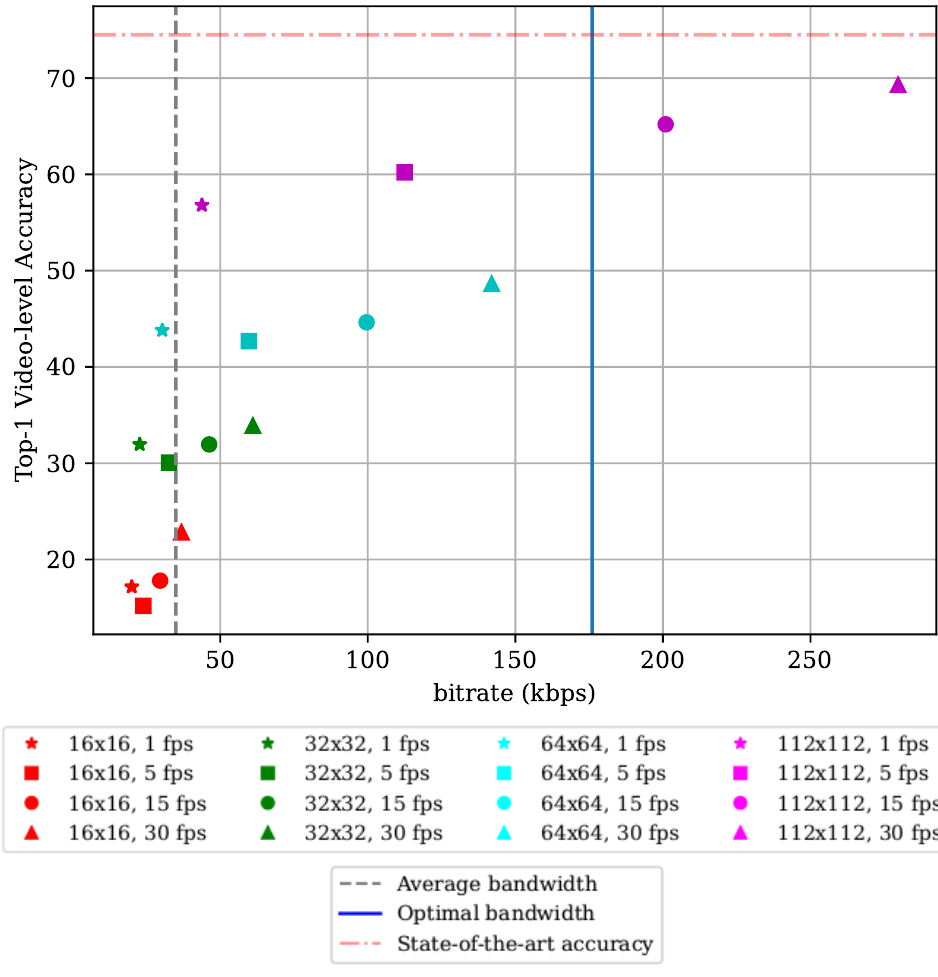
Figure 8. Plot over top-1 video-level accuracy ( y -axis) vs. bitrate required to perform real-time inference ( x -axis), including vertical lines indicating average and optimal bandwidth possible on our satellite connection. The different colors represent different resolutions of the video data used in fine-tuning the machine learning model, and the shapes are different frame rates. The horizontal line represents the top-1 video-level accuracy achieved by fine-tuning on HMDB51 in